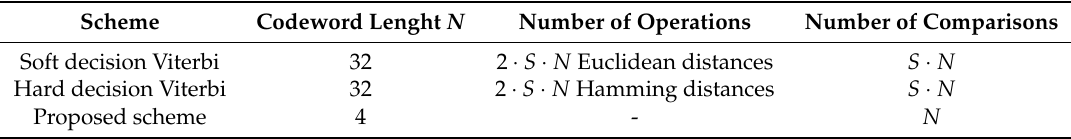
Table 2. Computational Complexity Analysis: S = 4 states of the two Viterbi